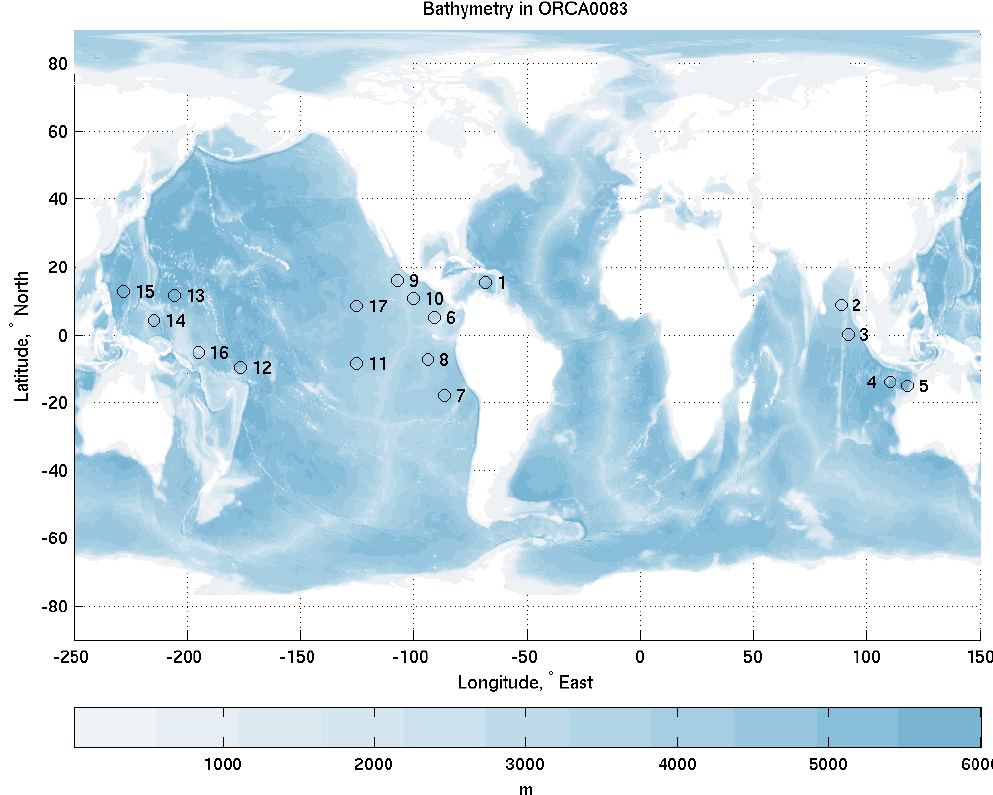
Figure 1. Locations of test sites and bathymetry from Nemo 1 / 12 ◦